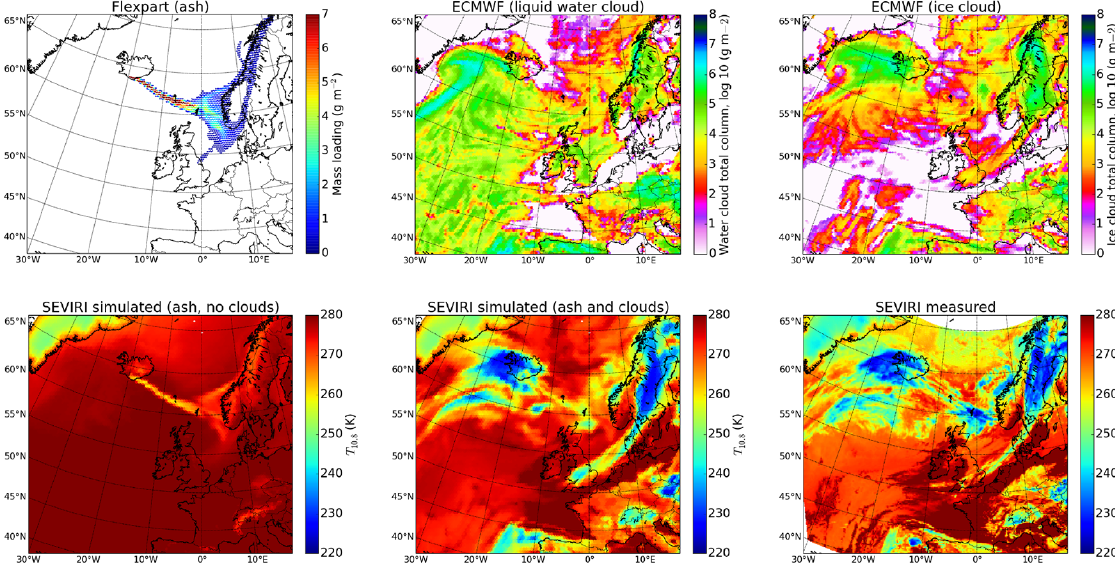
Figure 1. The total ash column as simulated by the Flexpart model (Upper left). Only pixels with column density above 0.2gm − 2 are shown. The total liquid water (upper centre) and ice water (upper right) cloud columns from ECMWF analysis data. The simulated cloudless (lower left) and cloudy (lower centre) 10.8µm brightness temperatures. (lower right) The measured brightness temperature of the 10.8µm SEVIRI channel. All data shown are for 12:00UTC, 15 April,